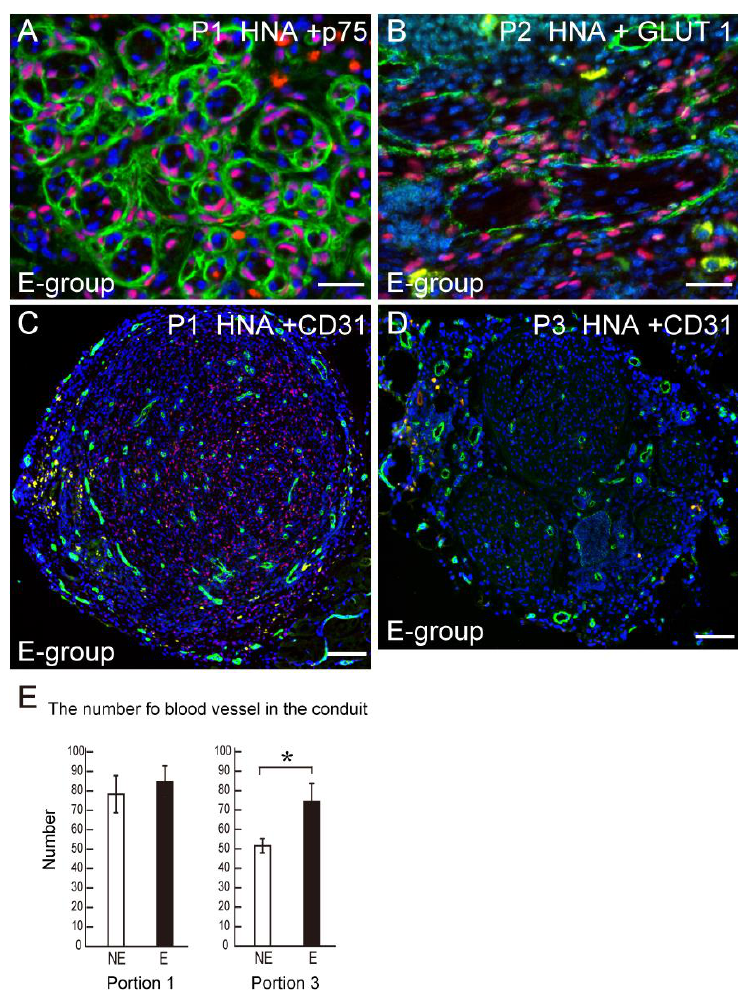
Figure 6. Differentiation of engrafted human Sk-34 cells into Schwann cells and perineurial cells, and the number of blood vessels in the bridging conduit. ( A ) Transplanted human Sk-34 cells (pink nuclei) expressed a newly formed Schwann cell marker p75 (green); ( B ) Transplanted human Sk-34 cells (pink nuclei) also formed new perineurium (green) showing differentiation into perineurial cells; ( C ) Typical staining of CD31 (green) as evidence of the number of blood vessels in the conduit. Blue staining in each panel is the nuclear staining of DAPI. P1 = position 1, P2 = position 2. Bars in A and B = 50 μm, C = 100 μm; ( D ) Statistical comparison of the formation of blood vessels in the conduit. There is no difference in the proximal Portion 1 between NE and E group, but a significantly higher value in ( E ) was observed in the distal end Portion 3. * p < 0.05.